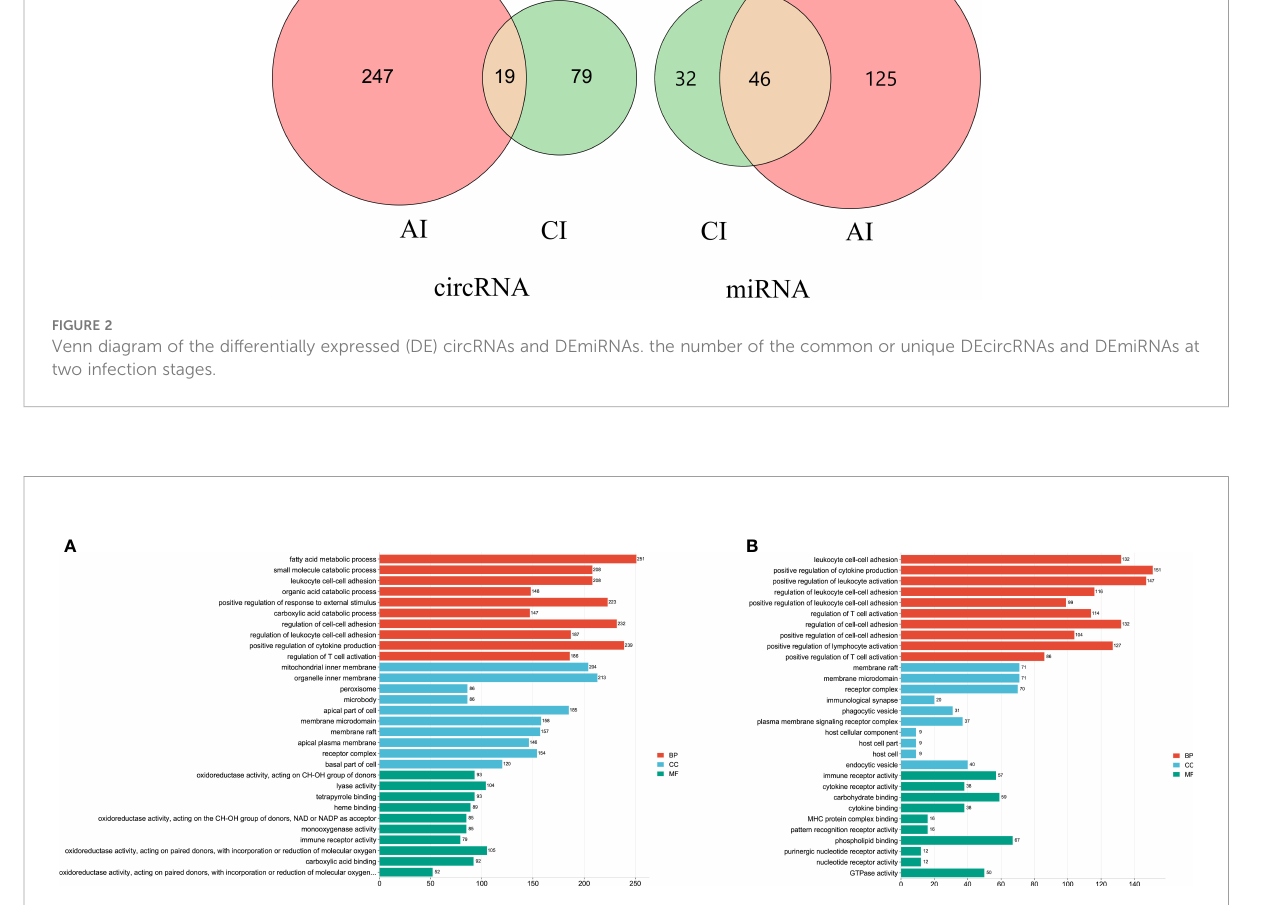
FIGURE 3 The top 30 GO terms of target genes of the differentially expressed (DE) miRNAs at acute infection (A) and chronic infection (B) stages. The vertical-axis represents the GO terms. The horizontal-axis represents numbers of target genes. The BP represents biological process, CC represents cellular component, and MF represents molecular